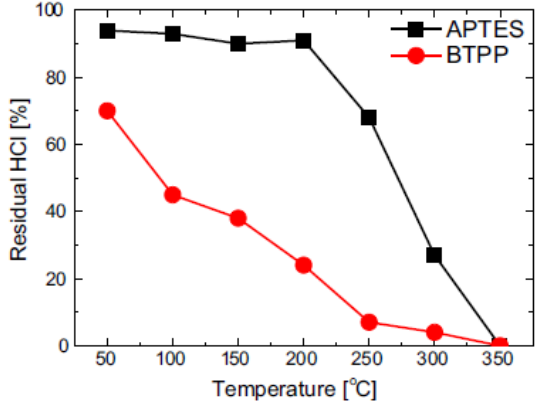
Figure 8. Temperature dependence of residual HCl in APTES and BTPP xerogel powders measured via EDS. The mole ratios of HCl/NH 2 = 1 for APTES and HCl/pyridine = 1 for BTPP were employed in the preparation of polymer sols. Prior to EDS measurement, APTES and BTPP xerogel powders prepared by drying the solvent of the sols at ~50 ◦ C, were fired under N 2 for 30 min at 50, 100, 150, 200, 250, 300, and 250 ◦ C. The molar compositions of the elements of Cl and Si were recorded and then the ratios of Cl/NH 2 for APTES and Cl/pyrimidine for BTPP were calculated by assuming molar ratios of Si over either NH 2 or pyrimidine groups that were the same as those of the associated precursors. Reproduced from ref. [21] with permission. Copyright (2017),